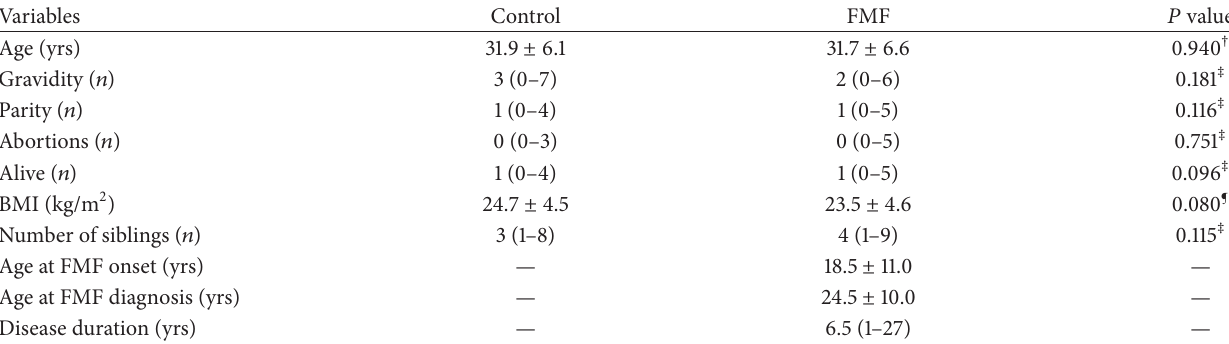
Table 1: Demographic and clinical characteristics of the groups.